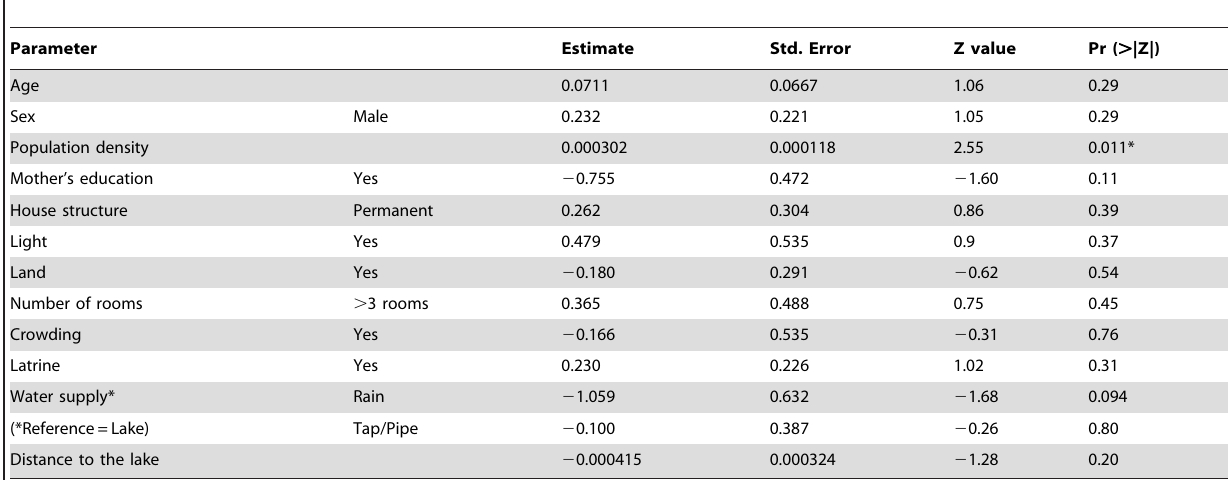
Table 5. Bivariate negative binomial generalized linear mixed model (NB-GLMM) for Schistosoma mansoni infection risk among schoolchildren Mbita, Kenya.